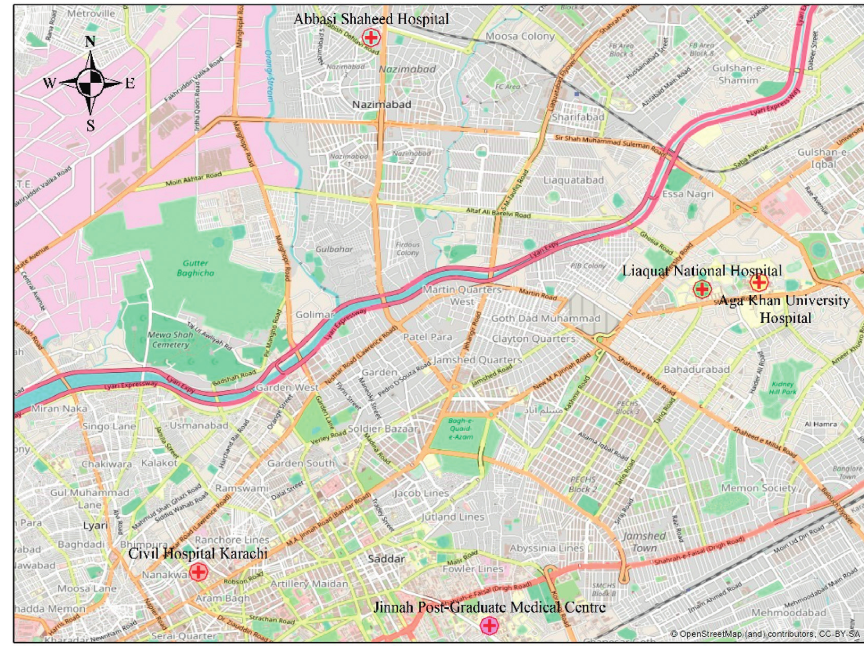
Figure 1: Location information of the medical